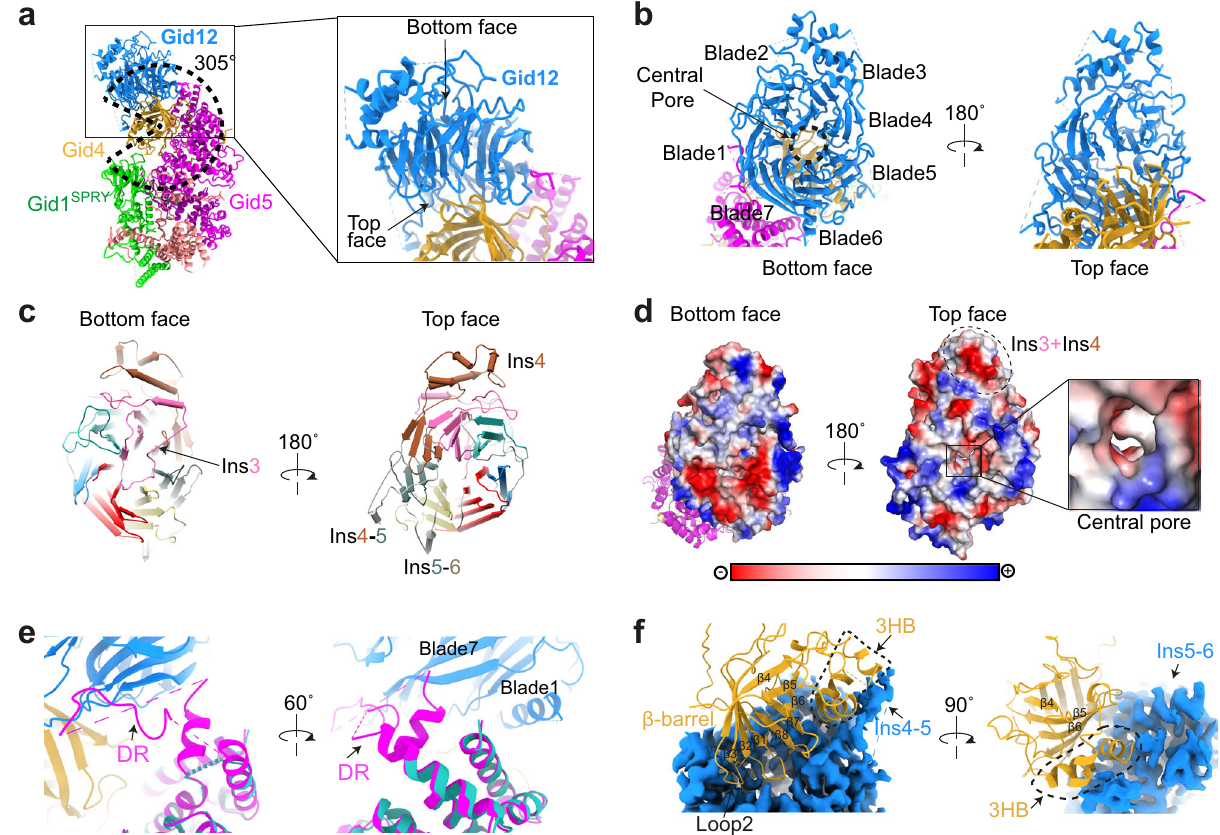
Fig. 2 Gid12 binds both the substrate receptor Gid4 and the tip of Gid5 in the scaffolding module. a Overall structure of Gid12-SRS. Gid12 is colored in blue, Gid4 in gold, Gid5 in magenta, Gid8 in salmon, and Gid1 in green. Dotted wedge highlights that Gid12 projects from the scaffolding module such that the substrate receptor, Gid4, is enwrapped around 305° in the complex. Closeup highlights interactions between Gid12, Gid4, and Gid5. b Gid12 forms a 7-bladed β -propeller, with its top face and central pore extensively interacting with Gid4, and edge binding Gid5. The β -propeller blades are labelled 1 – 7. c Gid12 structural elements, showing blades 1 – 7 from bottom and top faces of the β -propeller, color-coded in blue, green, hot pink, burnt orange, slate gray, khaki, and red, respectively. A meandering insertion in the 3rd blade (Ins3), indicated by the arrow, plugs the central pore from the bottom face of β - propeller (left); Insertion between the 3rd and 4th β -sheets in blade 4 (Ins4), insertion between blades 4 and 5 (Ins4-5), and insertion between blades 5 and 6 (Ins5-6) project outward from the center of the β -propeller (right). d Gid12 surface representation, colored by electrostatic surface potential. The bottom face is highly charged (red), whereas the top face, the surface of Ins3-Ins4 5-helix bundle, and central pore (see closeup), which interact with Gid4, are substantially hydrophobic (white). e Closeups of the superposition of Gid12-SRS with a prior structure without Gid12 (cyan, PDB ID: 6SWY) show that a ≈ 30-residue Gid5 disordered region (DR) — invisible in the published cryo-EM maps without Gid12 — binds an edge of Gid12 formed by blades 1 and 7. f Closeups showing extensive interactions between Gid12, shown as blue cryo-EM density, and Gid4 shown as gold ribbon. The Gid4 β -barrel interacts with the top face of Gid12. The Gid4 3-helix bundle (3HB) interacts with Ins4-5 and Ins5-6 from